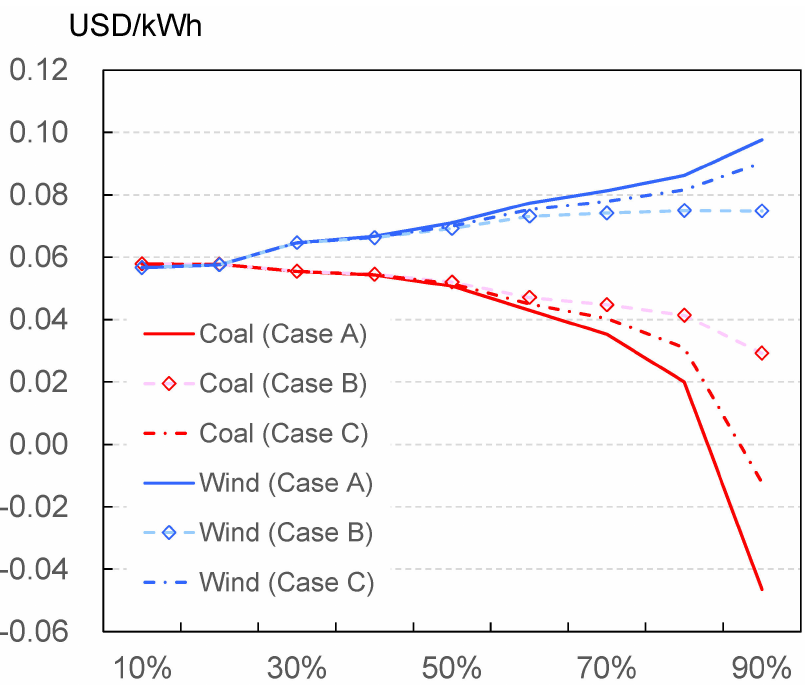
Figure 2. System